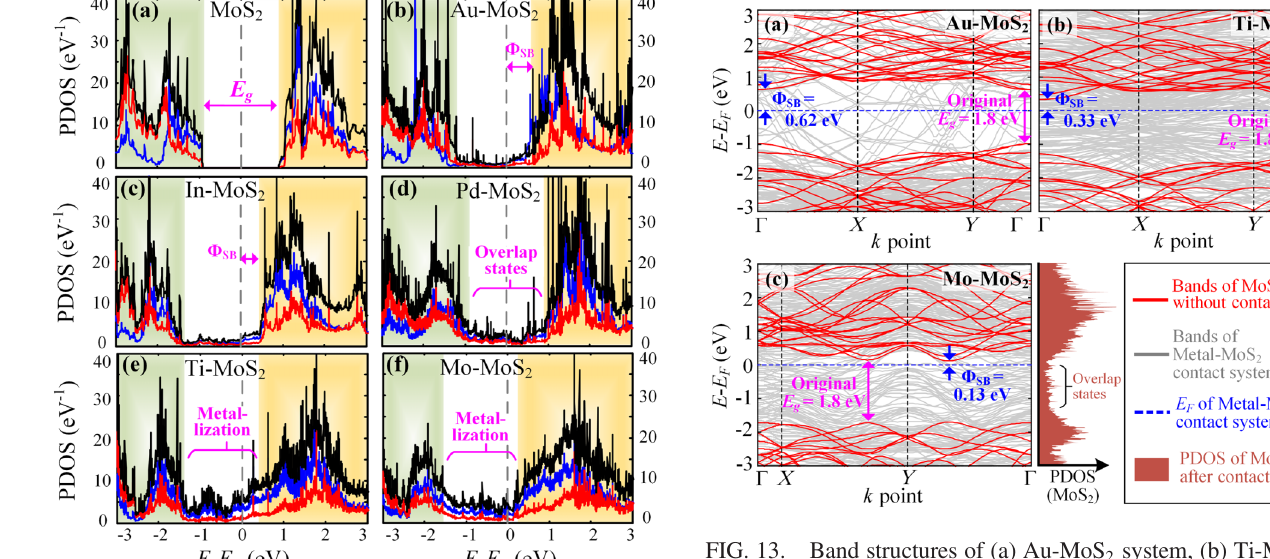
FIG. 13. Band structures of (a) Au-MoS 2 system, (b) Ti-MoS 2 system, and (c) Mo-MoS 2 system. The original band structure of MoS 2 without contact is also plotted for reference (red curves), which is superimposed on the new band structure (gray curves) such that old and new subbands align. The Schottky barrier ( Φ is marked in blue. Note that the symmetric points ( Γ , X , and Y ) FIG. 11. Partial density of states (PDOS) [DOS on specified are different between (a), (b), and (c) due to different dimensions atoms and orbitals, for example, Mo- d ( d orbital on Mo)] of top of the unit cells. PDOS of MoS 2 after contact by Mo is also contacts to MoS 2 : (a) only MoS 2 , (b) Au-MoS 2 , (c) In-MoS 2 , (d) Pd-MoS 2 , (e) Ti-MoS 2 , (f) Mo-MoS 2 . E shown in denotes Fermi level. F